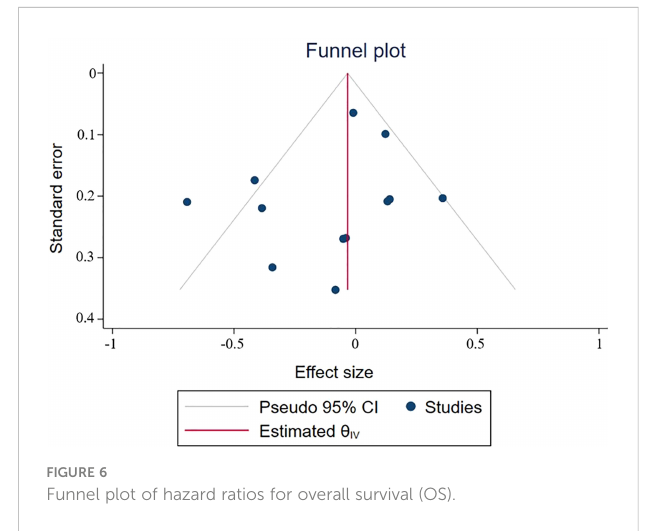
FIGURE 6 Funnel plot of hazard ratios for overall survival (OS).